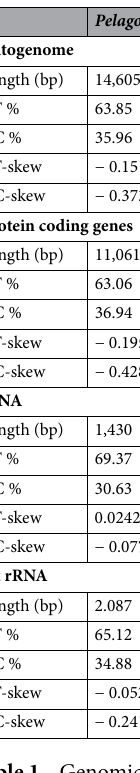
Table 1. Genomic features for each of the three newly constructed mitogenomes. Additional information for individual genes can be found in Supplementary Dataset